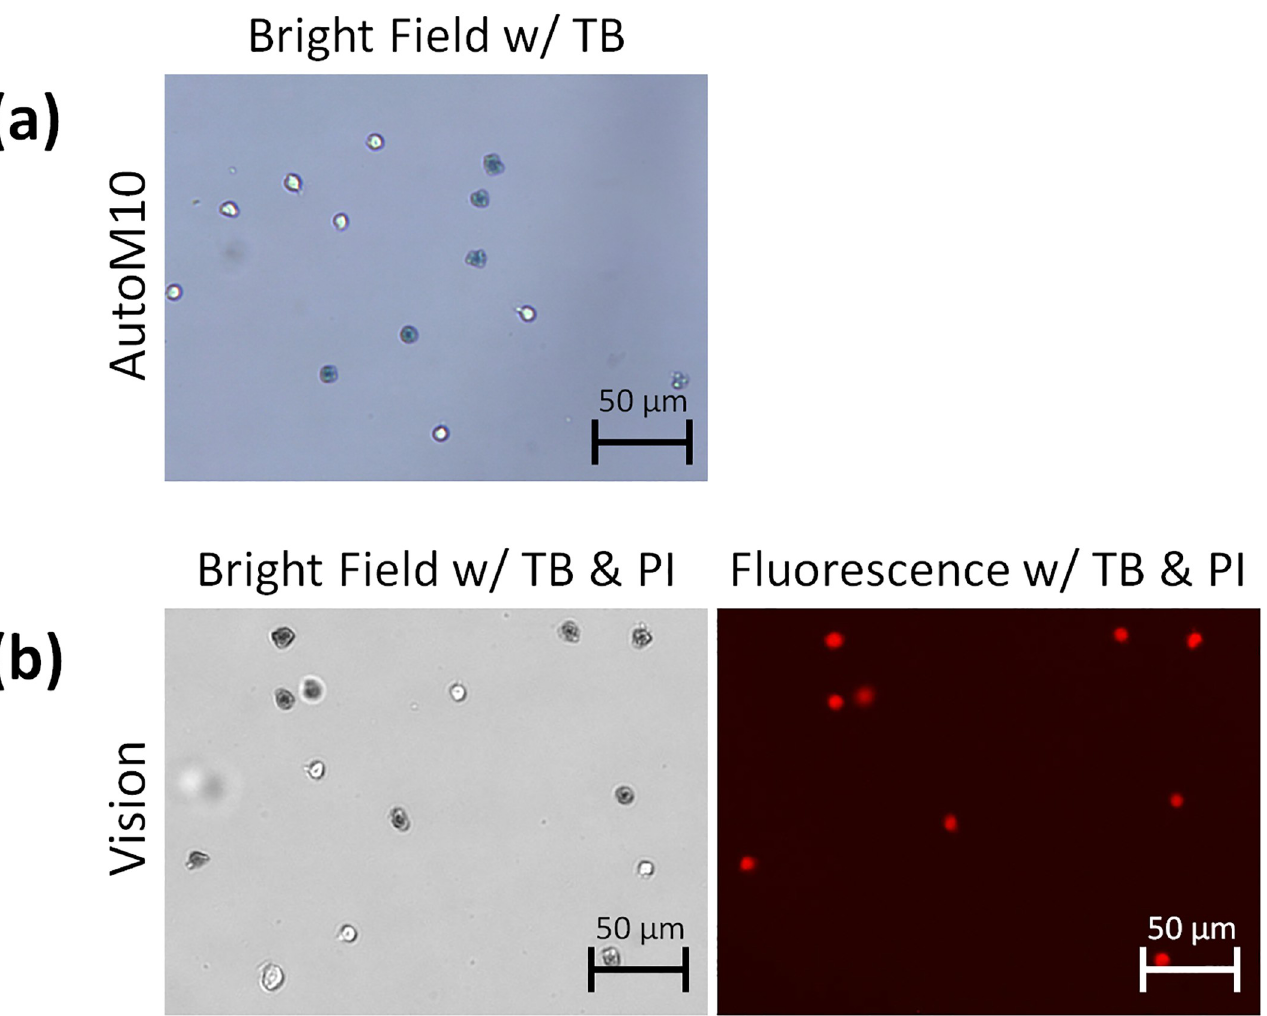
Fig 8. Bright field and fluorescent images of a 1:1 mixture of fresh and heat-killed Jurkat cells stained with trypan blue with or without propidium iodide. The cells were imaged using both AutoM10 and Vision 10X. (a) Unlike naturally dying cells, no membrane rupturing was observed, and heat-killed Jurkat cell morphology remained tight and dark when stained with trypan blue. (b) Co-localization of trypan blue and propidium iodide in heat-killed Jurkat